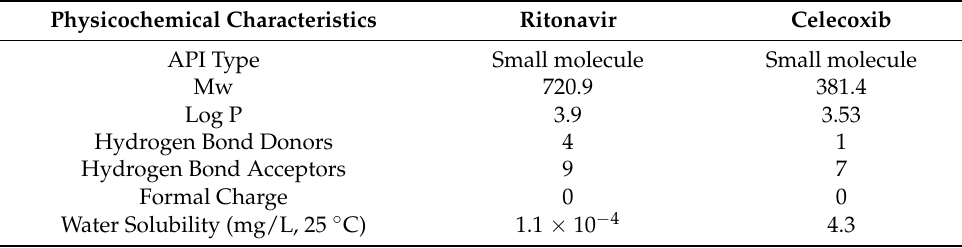
Table 9. Ritonavir and celecoxib physicochemical characteristics. Data obtained consulting PubChem and DrugBank databases.